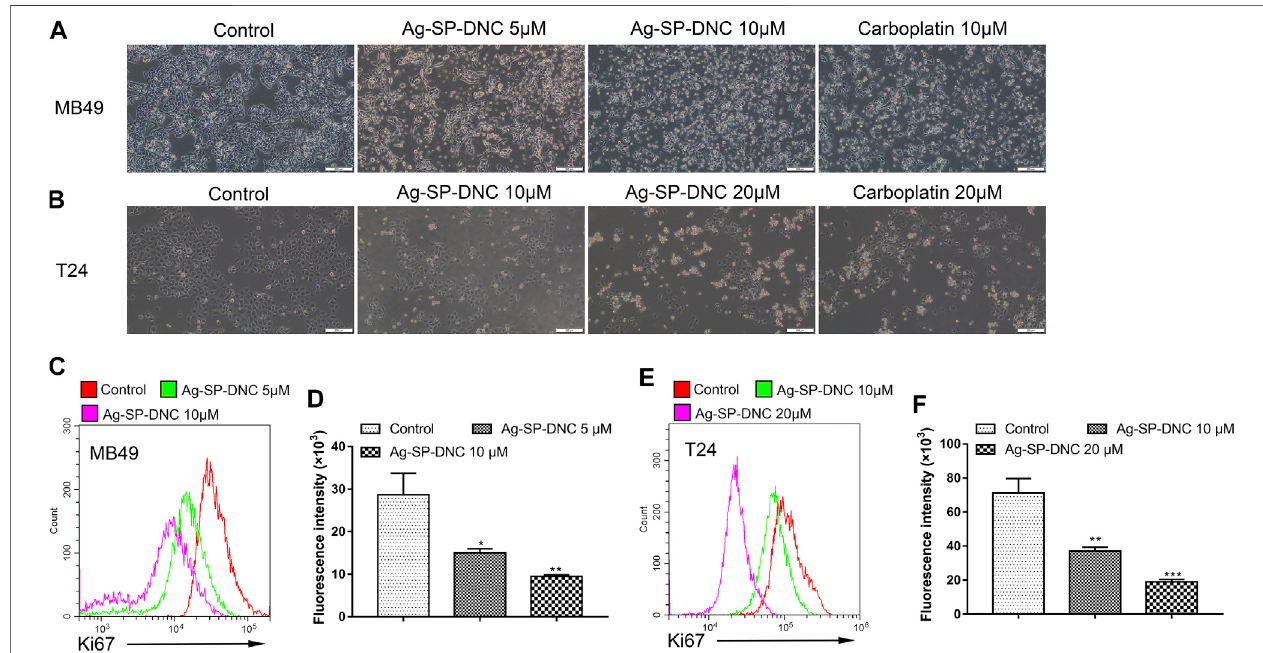
FIGURE2| Ag-SP-DNCshowspotentgrowthinhibitioninbladdercancercells invitro . (A) RepresentativeimagesofMB49treatedwithAg-SP-DNCorcarboplatin for 48 h. The representative fi elds were photographed at 100x magni fi cation. (B) Representative images of T24 treated with Ag-SP-DNC or carboplatin for 48 h. The fi eldswerephotographedat100xmagni fi cation. (C,D) Ki67expressionofMB49cellswasmeasuredby fl owcytometry. (C) Representativehistogramswereshown. (D) Cell associatedmean relative fl uorescence intensities. Dataare mean ± SEM;n (cid:1) 3. * p < 0.05, ** p < 0.01. (E , F) Ki67expression ofT24cells wasmeasured by fl ow cytometry. (E) Representative histograms were shown. (F) Cell associated mean relative fl uorescence intensities. Data are mean ± SEM; n (cid:1) 3. ** p < 0.01, *** p <